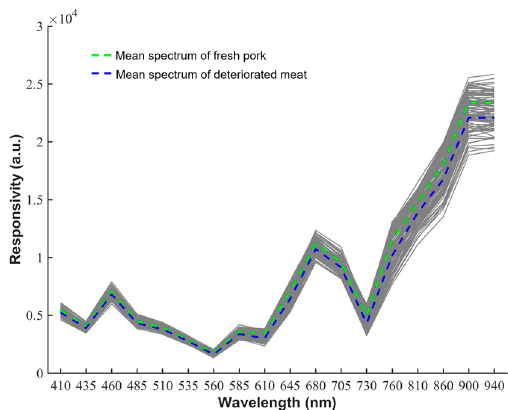
Figure 5. Diffuse reflectance multispectral (gray) of 96 pork samples with different